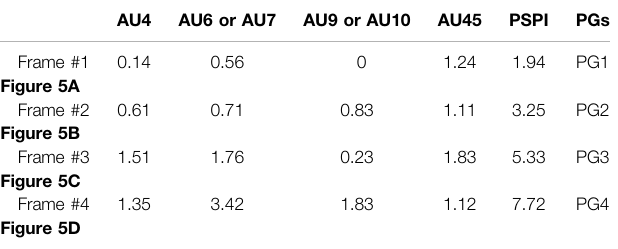
TABLE 3 | Discrimination of pain group (PG) based on PSPI result of record #107 from UNBC-McMaster Pain Shoulder